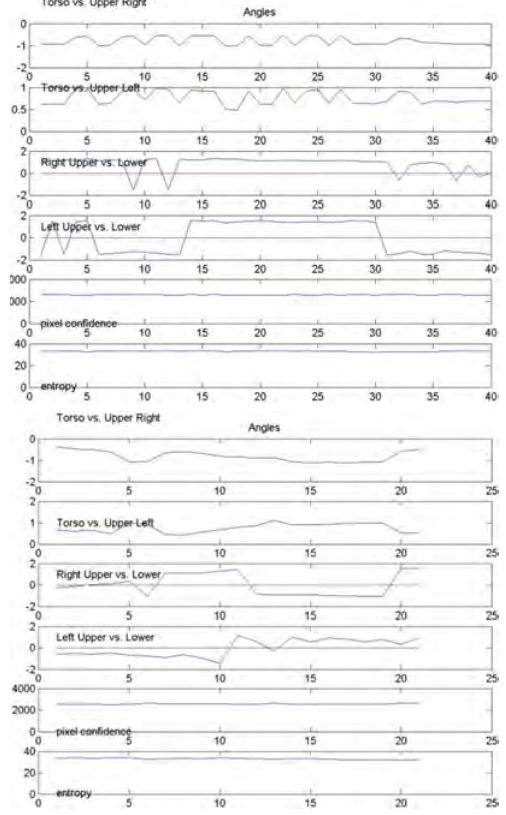
Figure 11. Motion angles pattern for two actions: (a) hands on the steering wheel (b) hands raised .